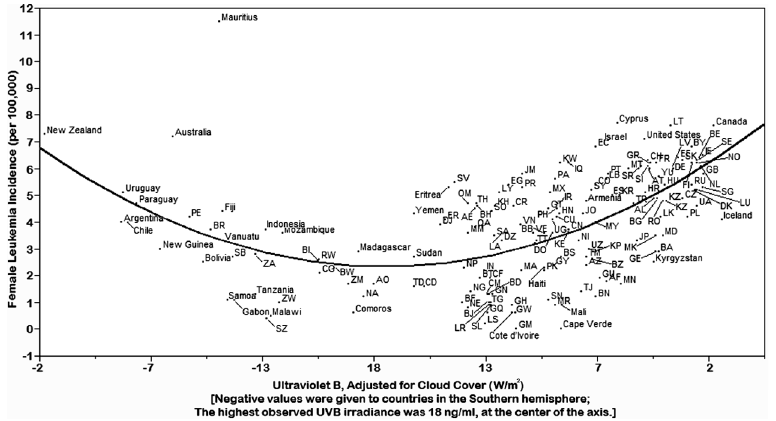
Fig 2. Rates of age-standardized leukemia incidence (cases per 100,000) in females according to cloud cover-adjusted UVB irradiance (W/m2), 172 countries, 2012.